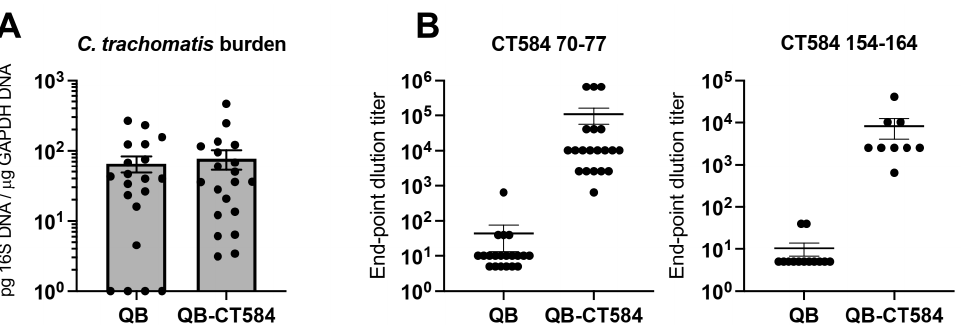
Figure 4. Immunogenicity and protective capacity of vaccine Q β -CT584. A second, statistically- powered vaccine trial ( n = 20/group) was performed to assess the protective capacity and immuno- genicity of Q β -CT584. ( A ) Bacterial burden in the upper genital tract of female mice immunized with either Q β -CT584 or the negative control Q β alone was measured by qPCR. ( B ) Immunization with Q β -CT584 induced high titer IgG specific to vaccine epitopes CT584 70-77 ( p < 0.0001) and CT584 154-164 ( p < 0.0001) as measured by ELISA. End point dilution was defined as the reciprocal of the highest sample dilution with an OD450 reading twice that of blank wells. Horizontal lines represent means +/ −